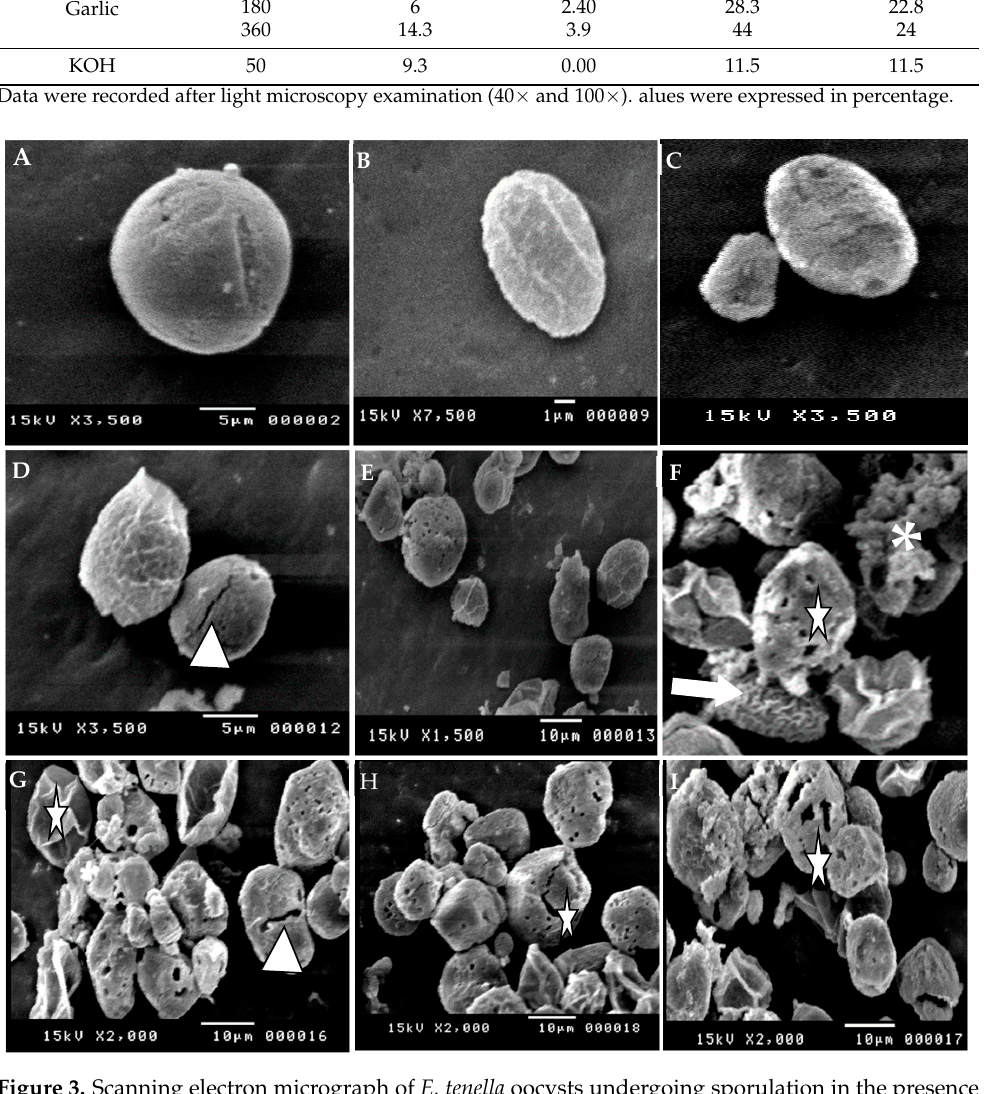
oocysts contracted or shrank as a result of the lysed contents. Also observed was the loss